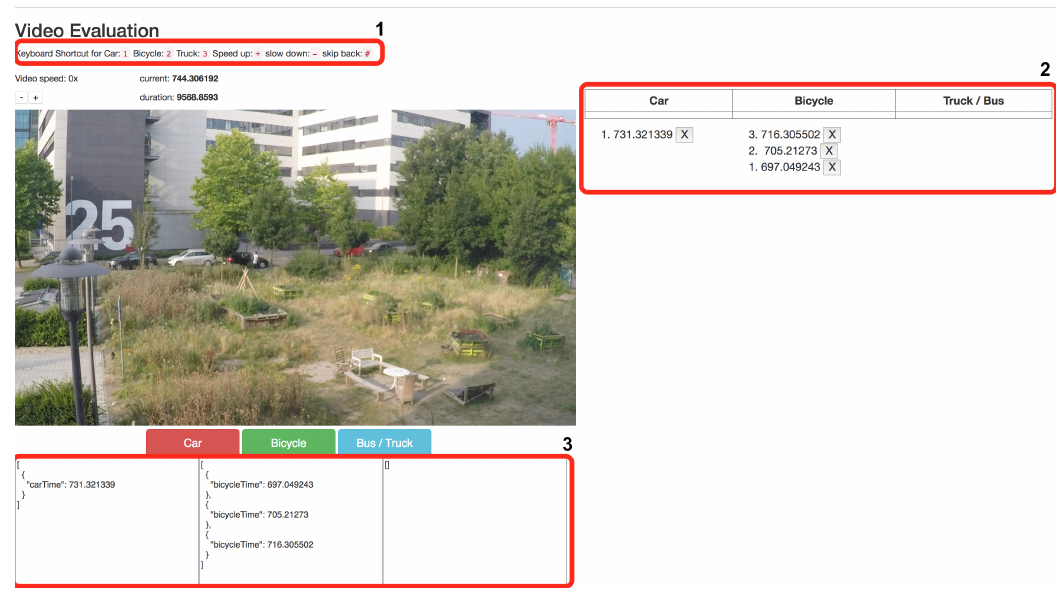
Figure 4. Illustration of the web-application developed for ground-truth data video stream analysis.